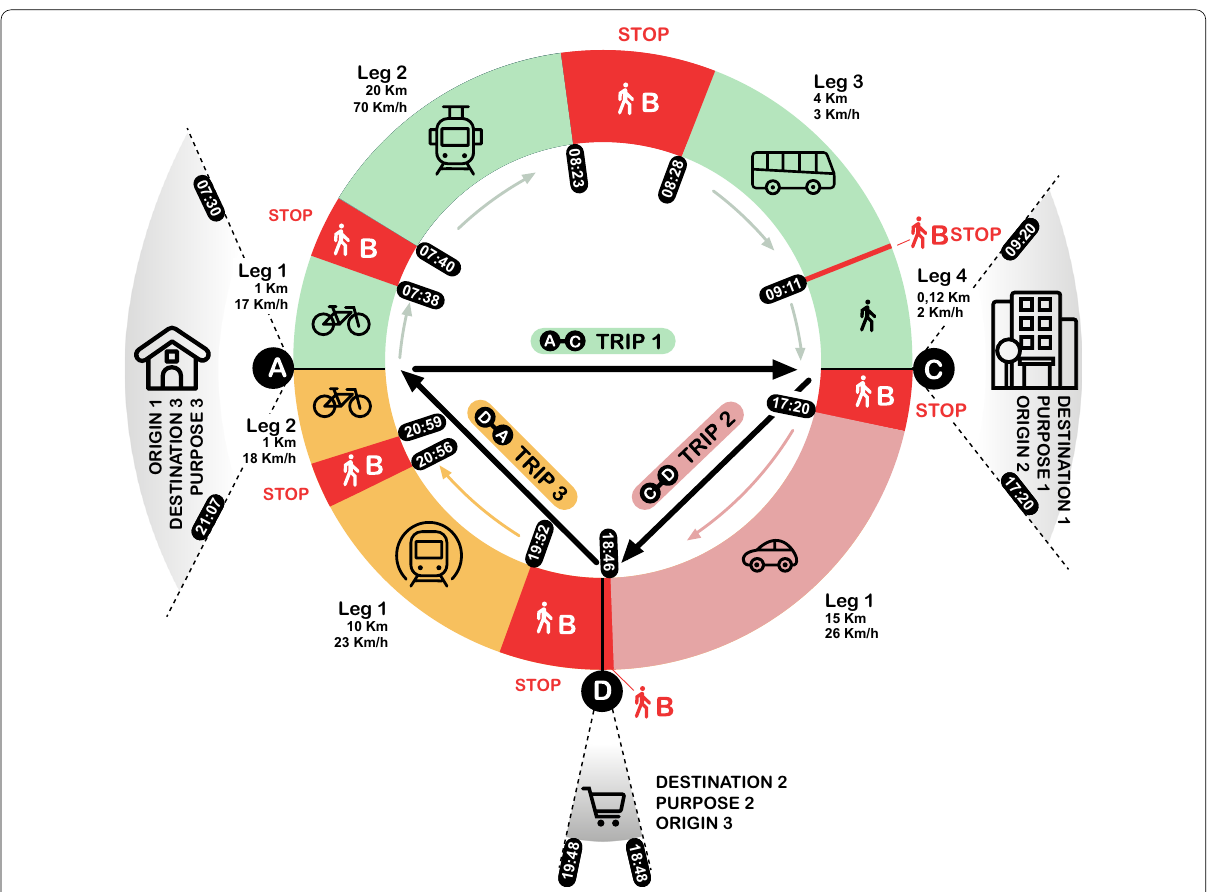
Fig. 1 Tour components and travel